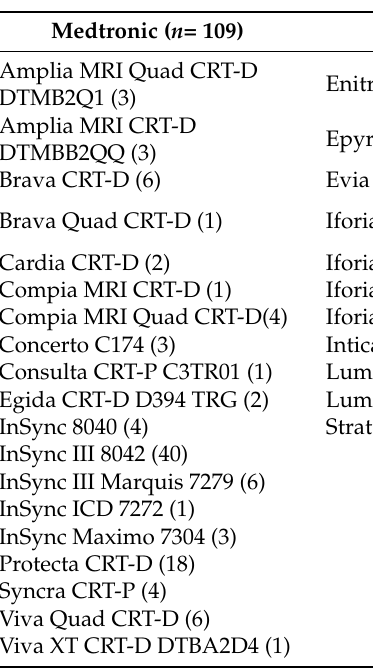
Table 2. Implanted devices and manufacturer.